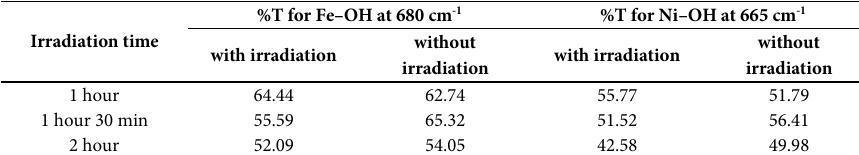
Table 2. %Transmittance values of Fe–OH and Ni–OH bond vibrations